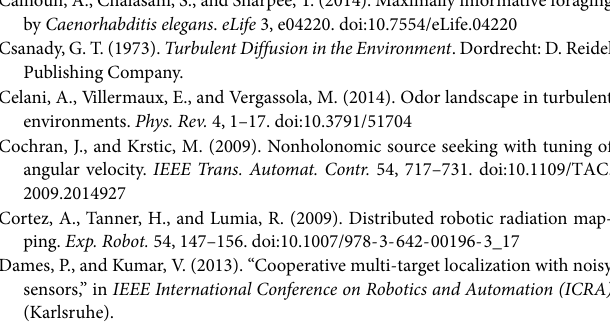
estimated over 20 trials for robotic experiments (same parameters as in Figure 1A ). Red and blue plots are for swarm Mapless and independent searchers, respectively. (B) Example of swarm Mapless trajectory with three